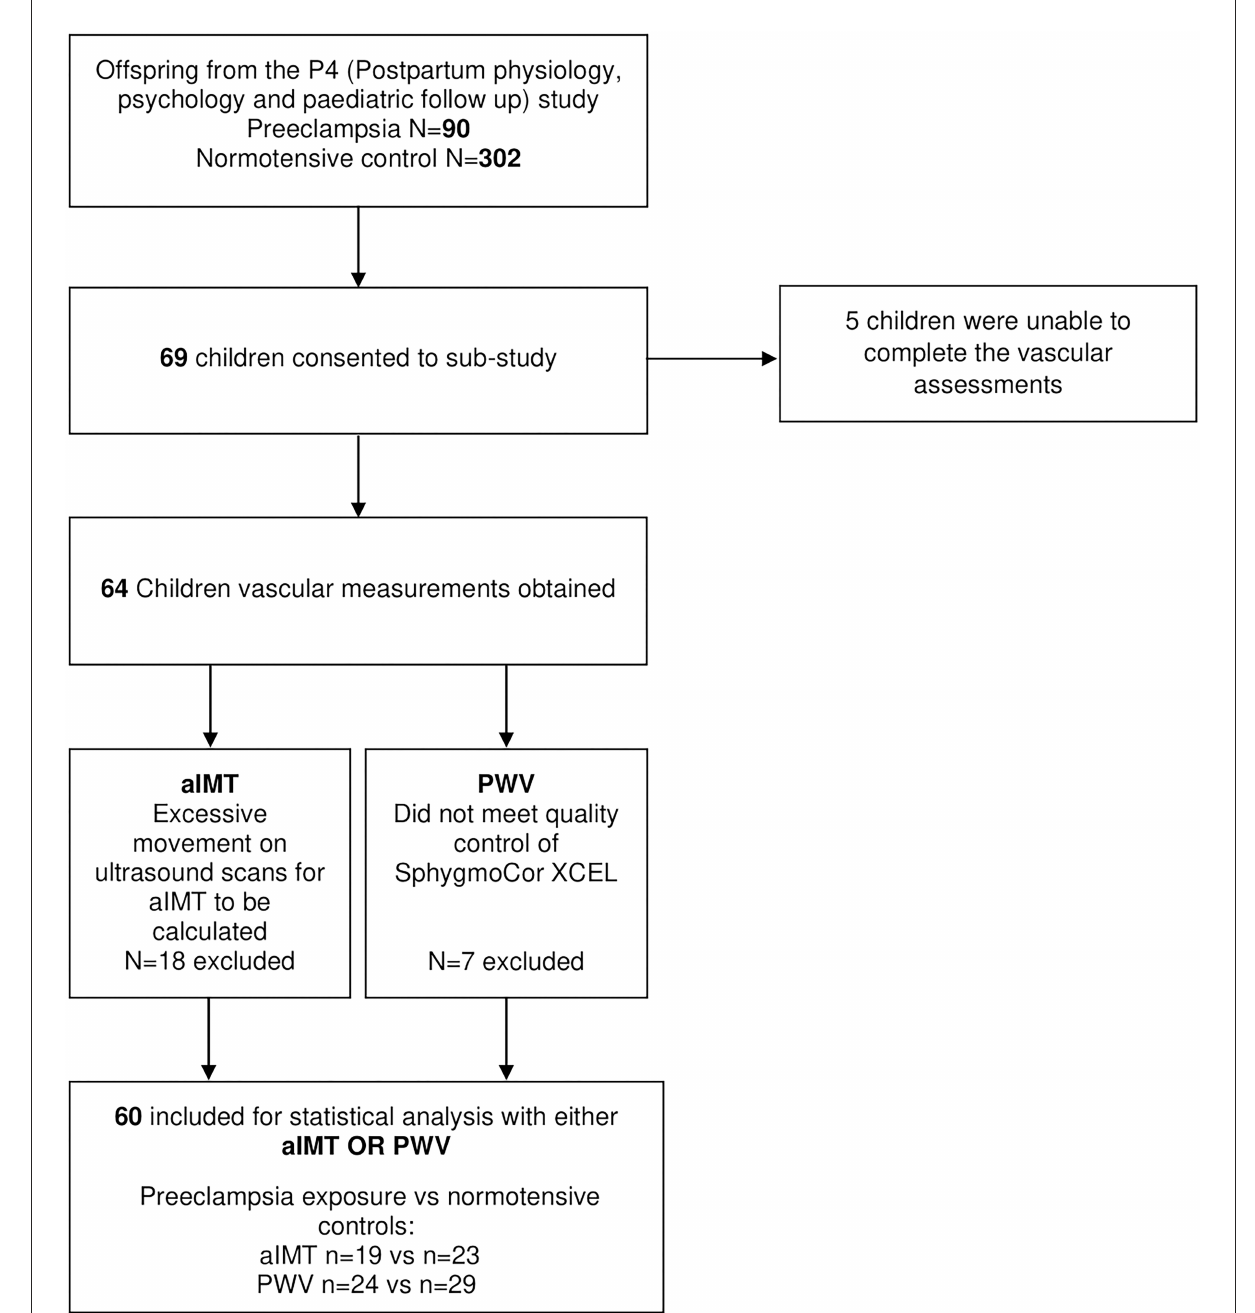
FIGURE1 Participant recruitment and analysis flow diagram.